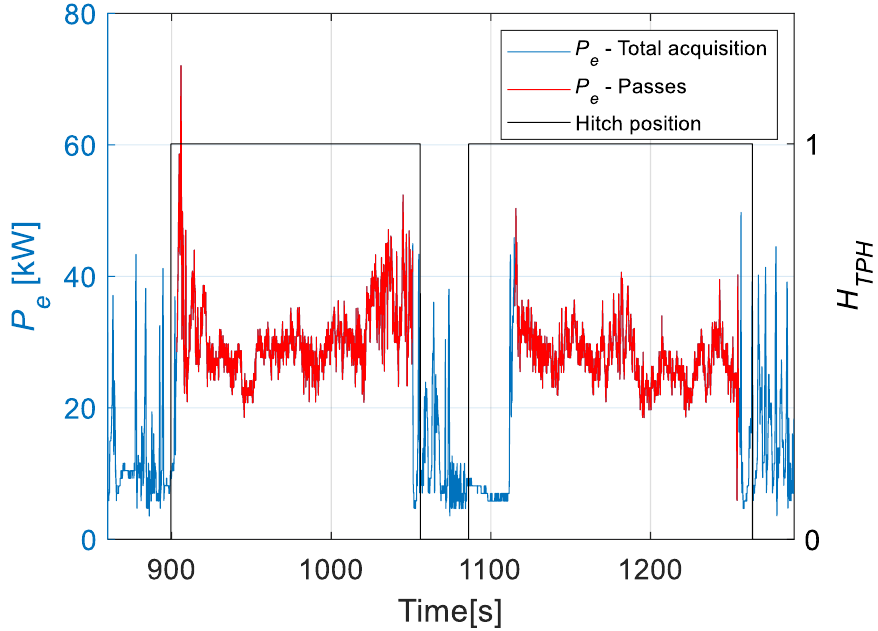
Figure 4. Separation of the passes from the headland turns observing the rate of change of Pe , calculated with signal differentiation, and the value of the signal H tph that is equal to 1 when the TPH is in working position and 0 when it is lifted from the ground.